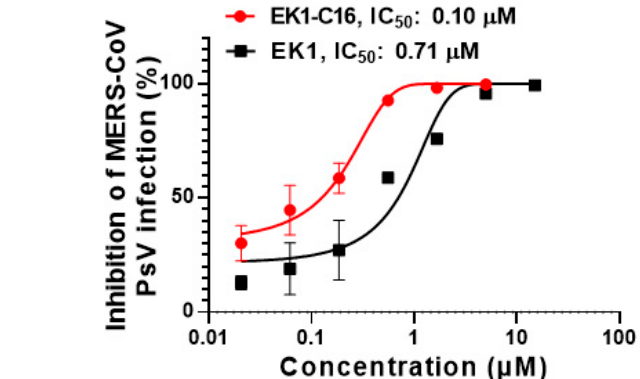
MERS-CoV spike protein-mediated cell–cell fusion. ( B ) Inhibitory activity of EK1-C16 Figure 5. EK1-C16 can broadly inhibit MERS-CoV infection. ( A ) Inhibitory activity of EK1-C16